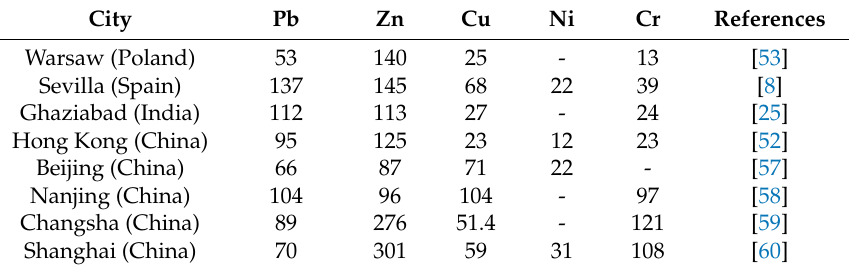
Table 3. The average soil metal concentrations (mg/kg d.m.) in urban areas of different world cities. City Pb Zn